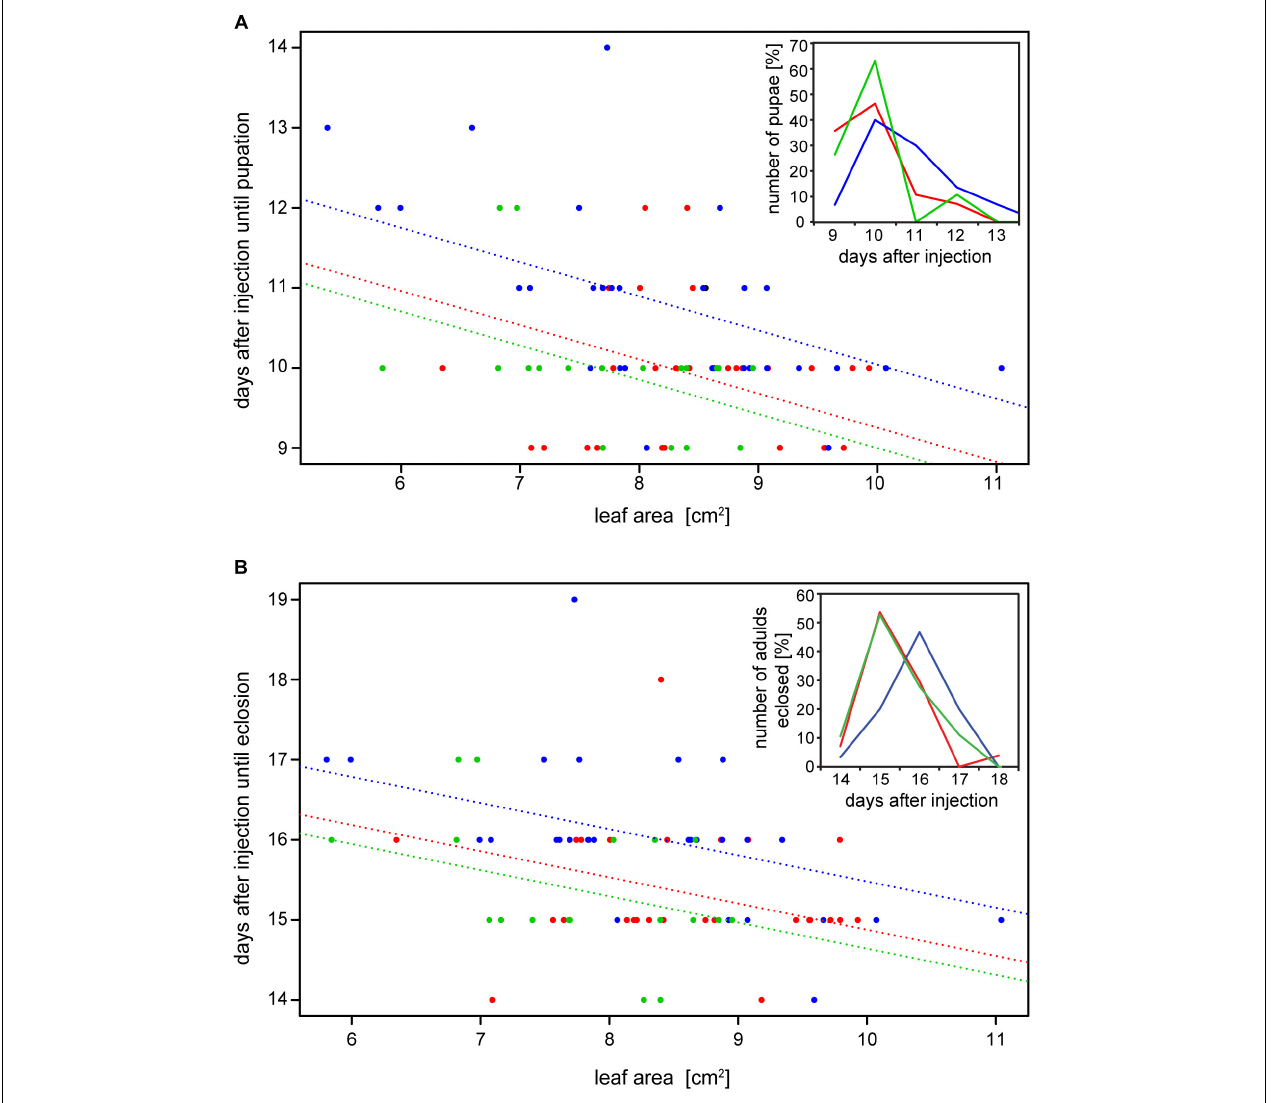
FIGURE 5 | Dependency of (A) time to pupation and (B) time to eclosion from the amount of the consumed leaf area and the treatment (GFP: red, 28a: green and 28i: blue). Insertions show the number of pupae and adults that emerged in percentages over days after injection,